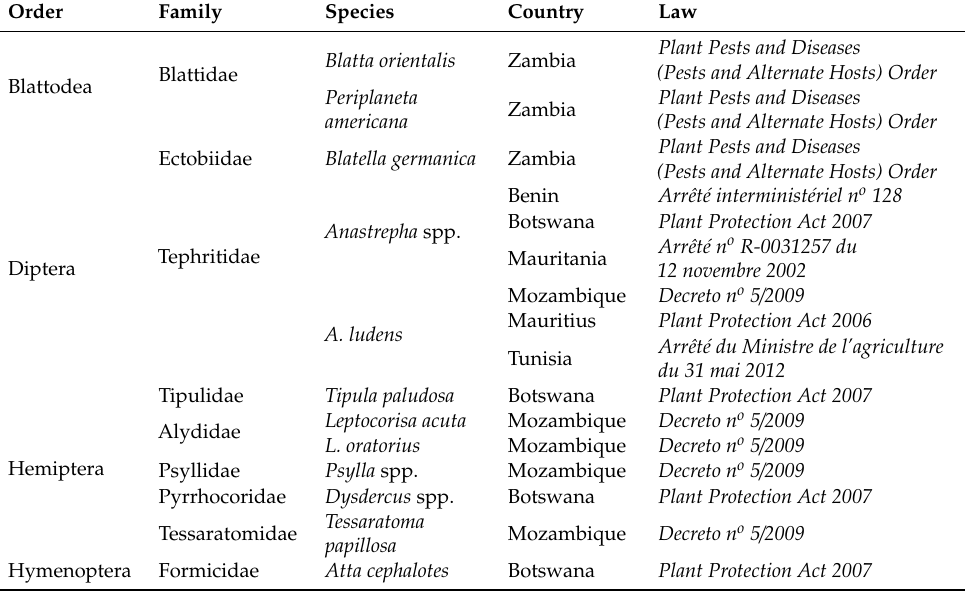
Table 10. Pest insect legislation pertaining edible insect species (as presented in [11]): other orders.